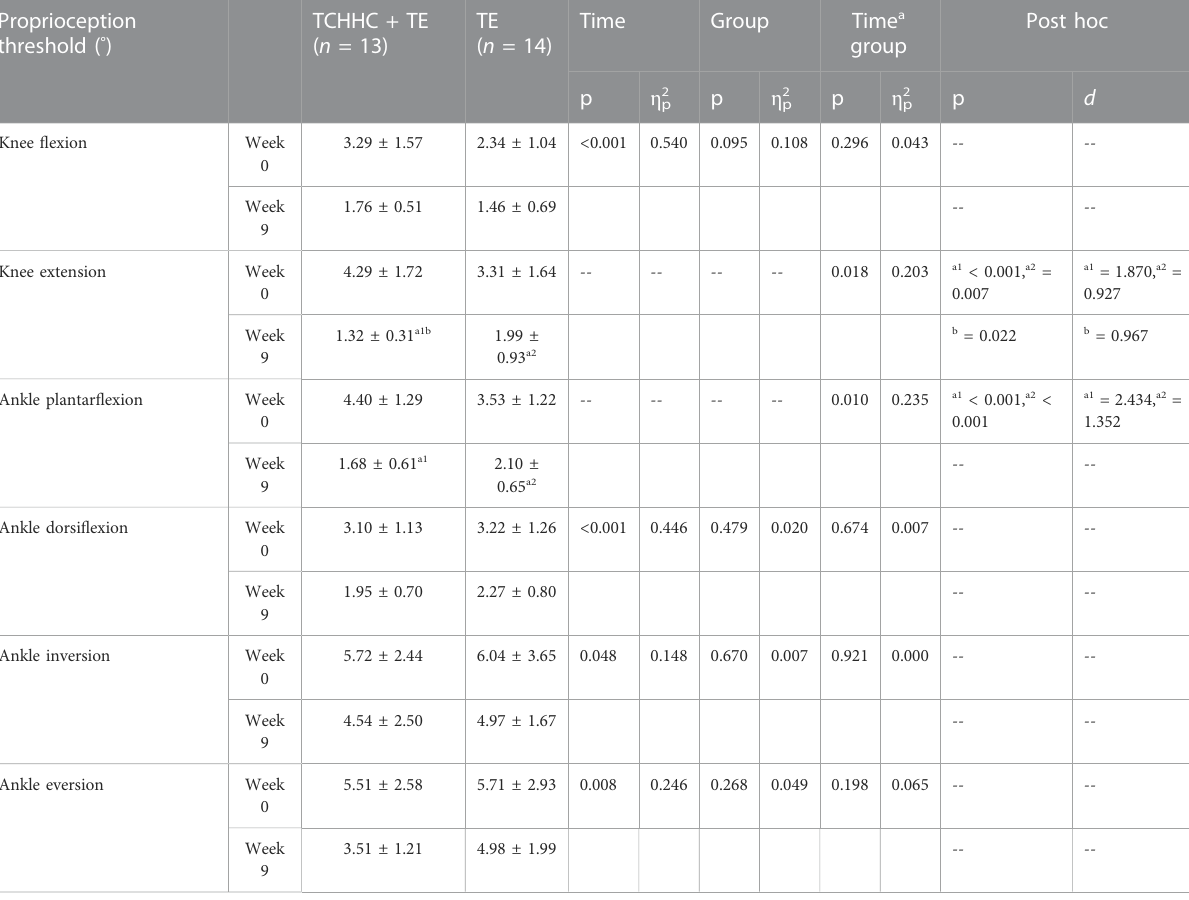
TABLE 4 Proprioception thresholds of the more affected knee joint, ankle sagittal plane, and ankle frontal plane at weeks 0 and 9. Proprioception threshold ( ° )